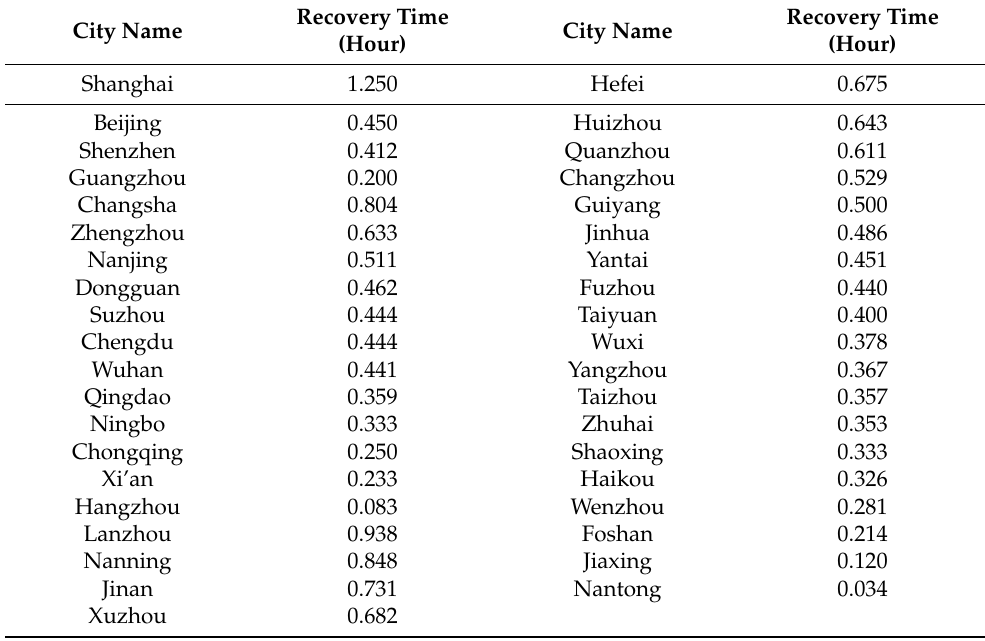
Figure 3. Recovery time of each city after precipitation. Table 3. Recovery time of each city after precipitation.